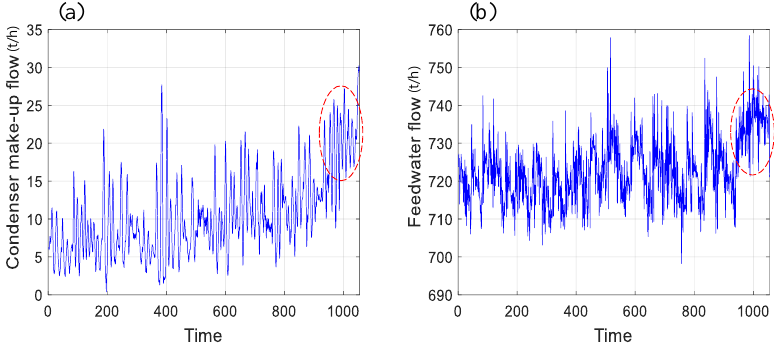
Figure 13. (Failure data due to waterwall tube leakage) Trajectories of faulty variables related to waterwall tube leakage: ( a ) condenser make-up flow (t/h) ( x 8 ); ( b ) feedwater flow (t/h) ( x 9 ).